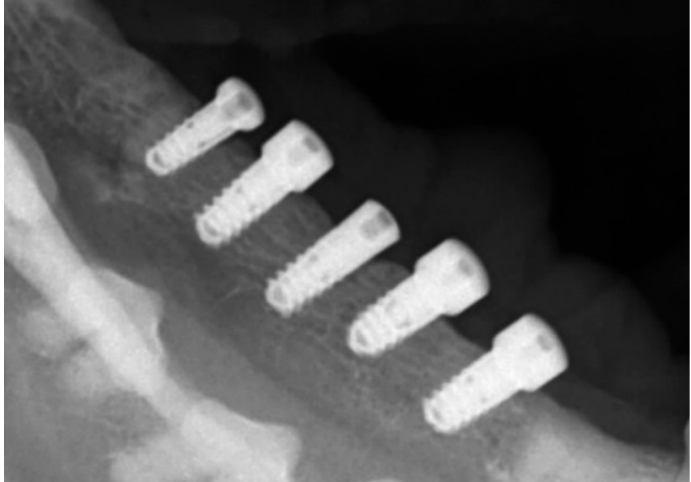
Figure 5. Radiological follow-up immediately after the abutment connection, revealing no post-im- plantation pre-exposure bone loss around the